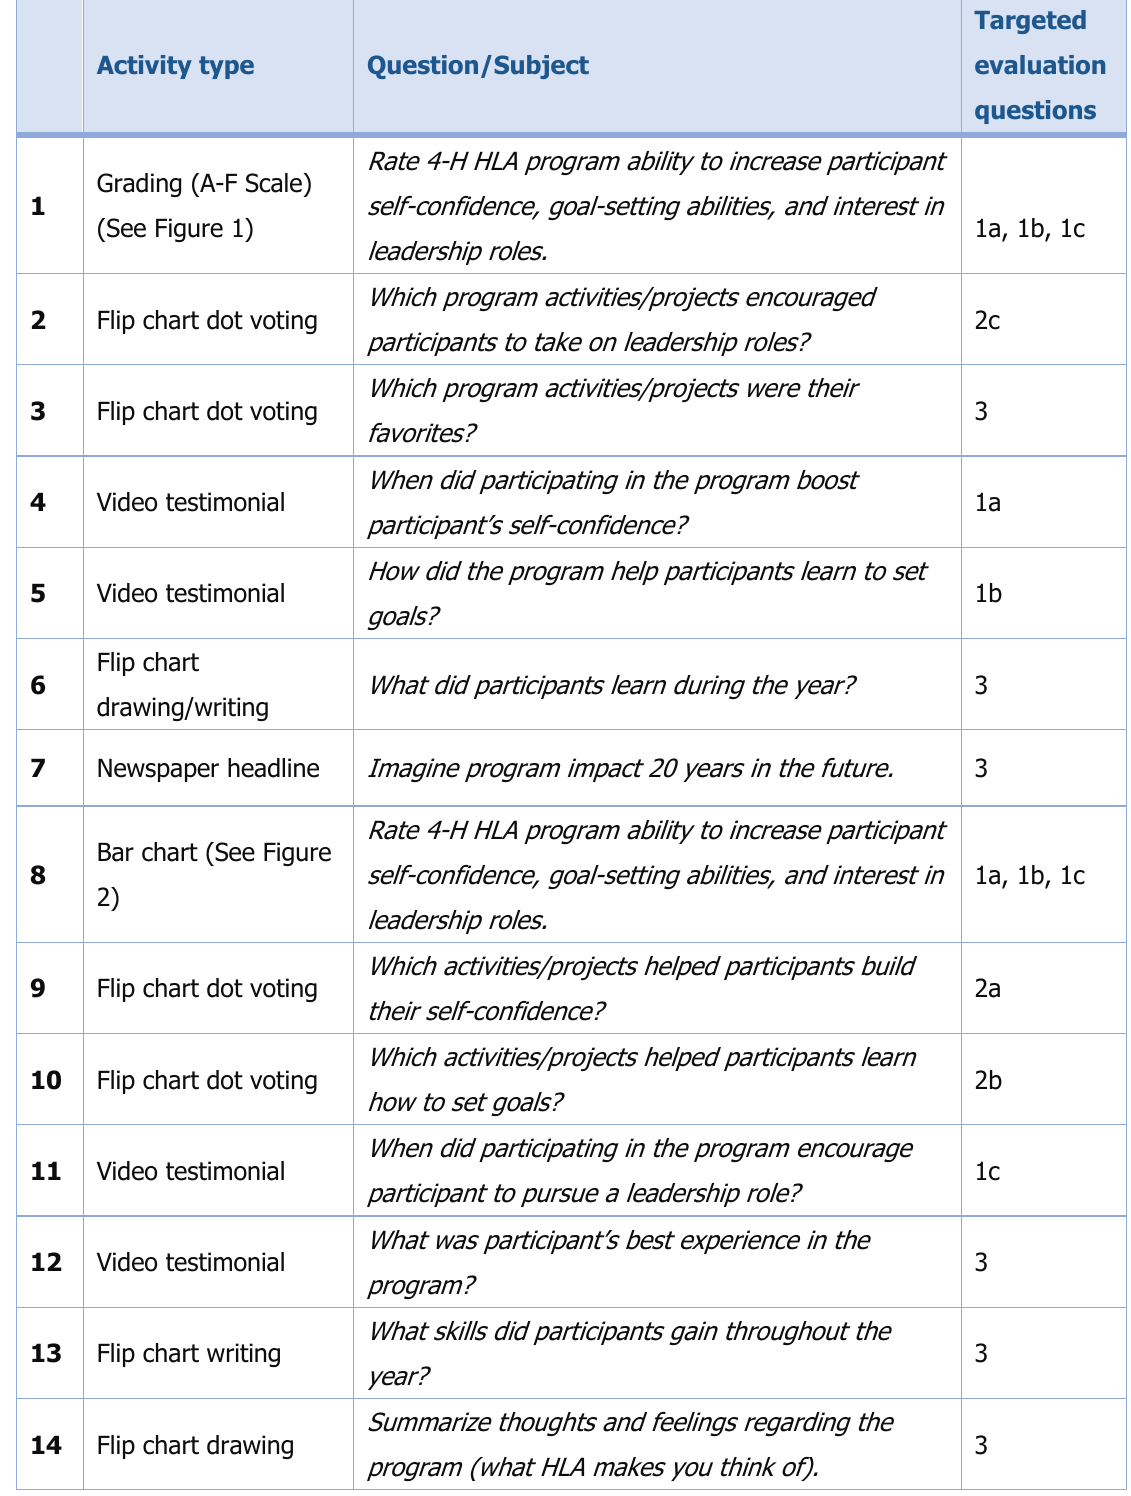
Table 1. Evaluation Skill-a-Thon Activities